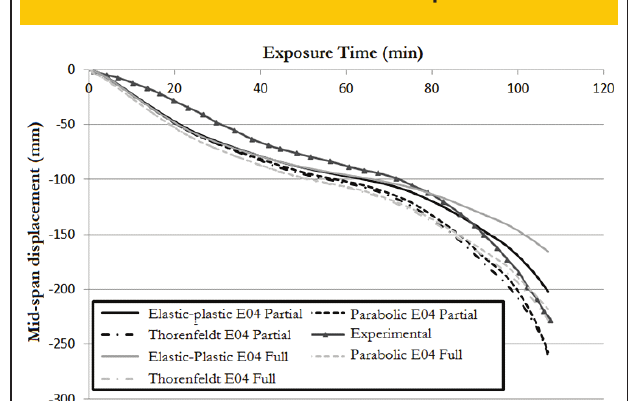
Figure 15 – Comparison of the results using full and partial interaction for the models with the 280 ASB 100 steel